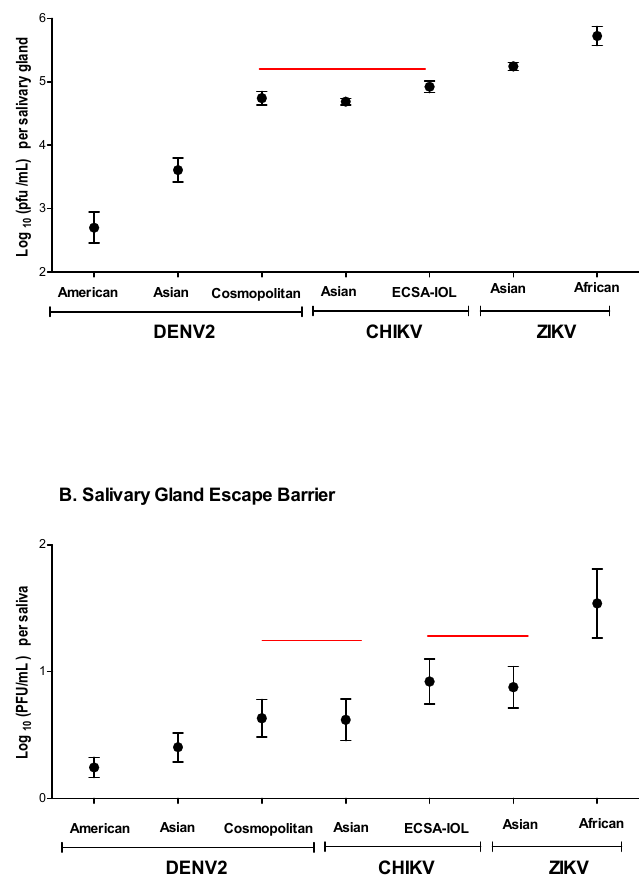
Figure 5. ( A ) Average numbers of log 10 (PFU/mL) per salivary gland for all seven viral genotypes. ( B ) Average numbers of log 10 (PFU/mL) per saliva were calculated for all seven viral genotypes. Horizontal lines over pairs of genotypes in either graph indicate that average log 10 (PFU/mL) per salivary gland did not differ significantly. When comparing genotypes across the same virus family (DENV2, CHIKV, and ZIKV), genotype titer means for DENV2 and ZIKV were significantly different ( p < 0.0001). Of all viruses tested, DENV2 American had the lowest virus titer (2.699 ± 0.58 log 10 (PFU/mL)), while ZIKV African had the highest titer (5.723 ± 0.331 log 10 (PFU/mL)). DENV2 Cosmopolitan had the highest virus titer (4.742 ± 0.23 log 10 (PFU/mL)) between DENV2 genotypes, while DENV2 Asian (3.607 ± 0.0421 log 10 (PFU/mL)) was the second lowest of all viruses tested. CHIKV ECSA-IOL had slightly higher titers (4.921 ± 0.206 log 10 (PFU/mL)) as compared to CHIKV Asian (4.687 ± 0.711 log 10 (PFU/mL)). CHIKV genotypes had the same titers as DENV2 Cosmopolitan ( p = 0.3294). Both ZIKV genotypes (Asian, 5.244 ± 0.136 log 10 (PFU/mL); African, 5.723 ± 0.331 log 10 (PFU/mL)) exhibited the highest